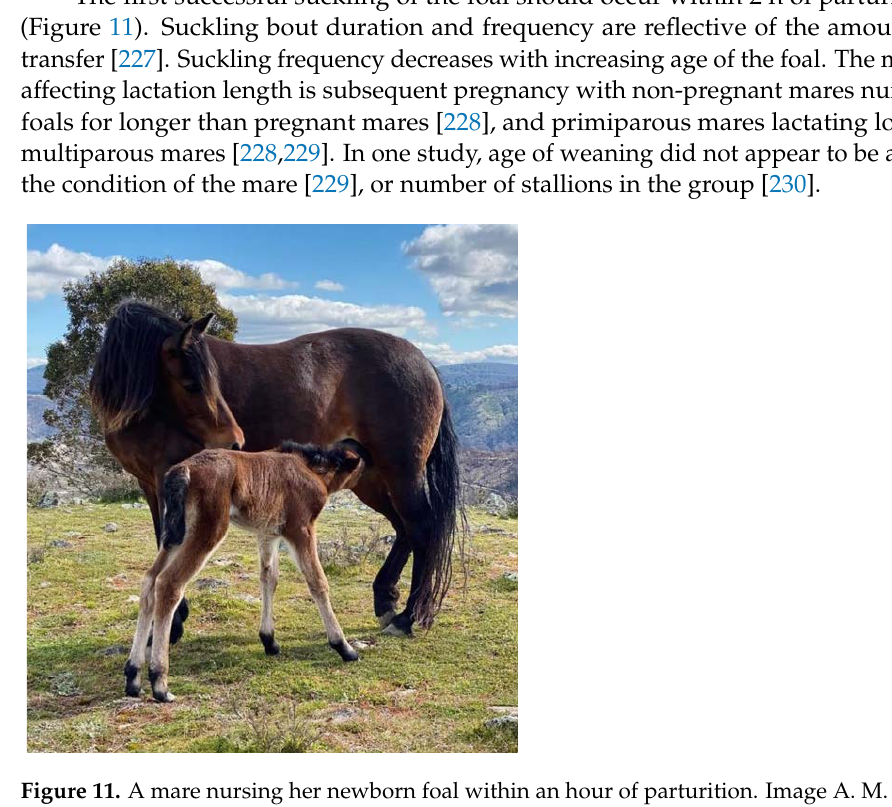
Figure 11. A mare nursing her newborn foal within an hour of parturition. Image A. M.